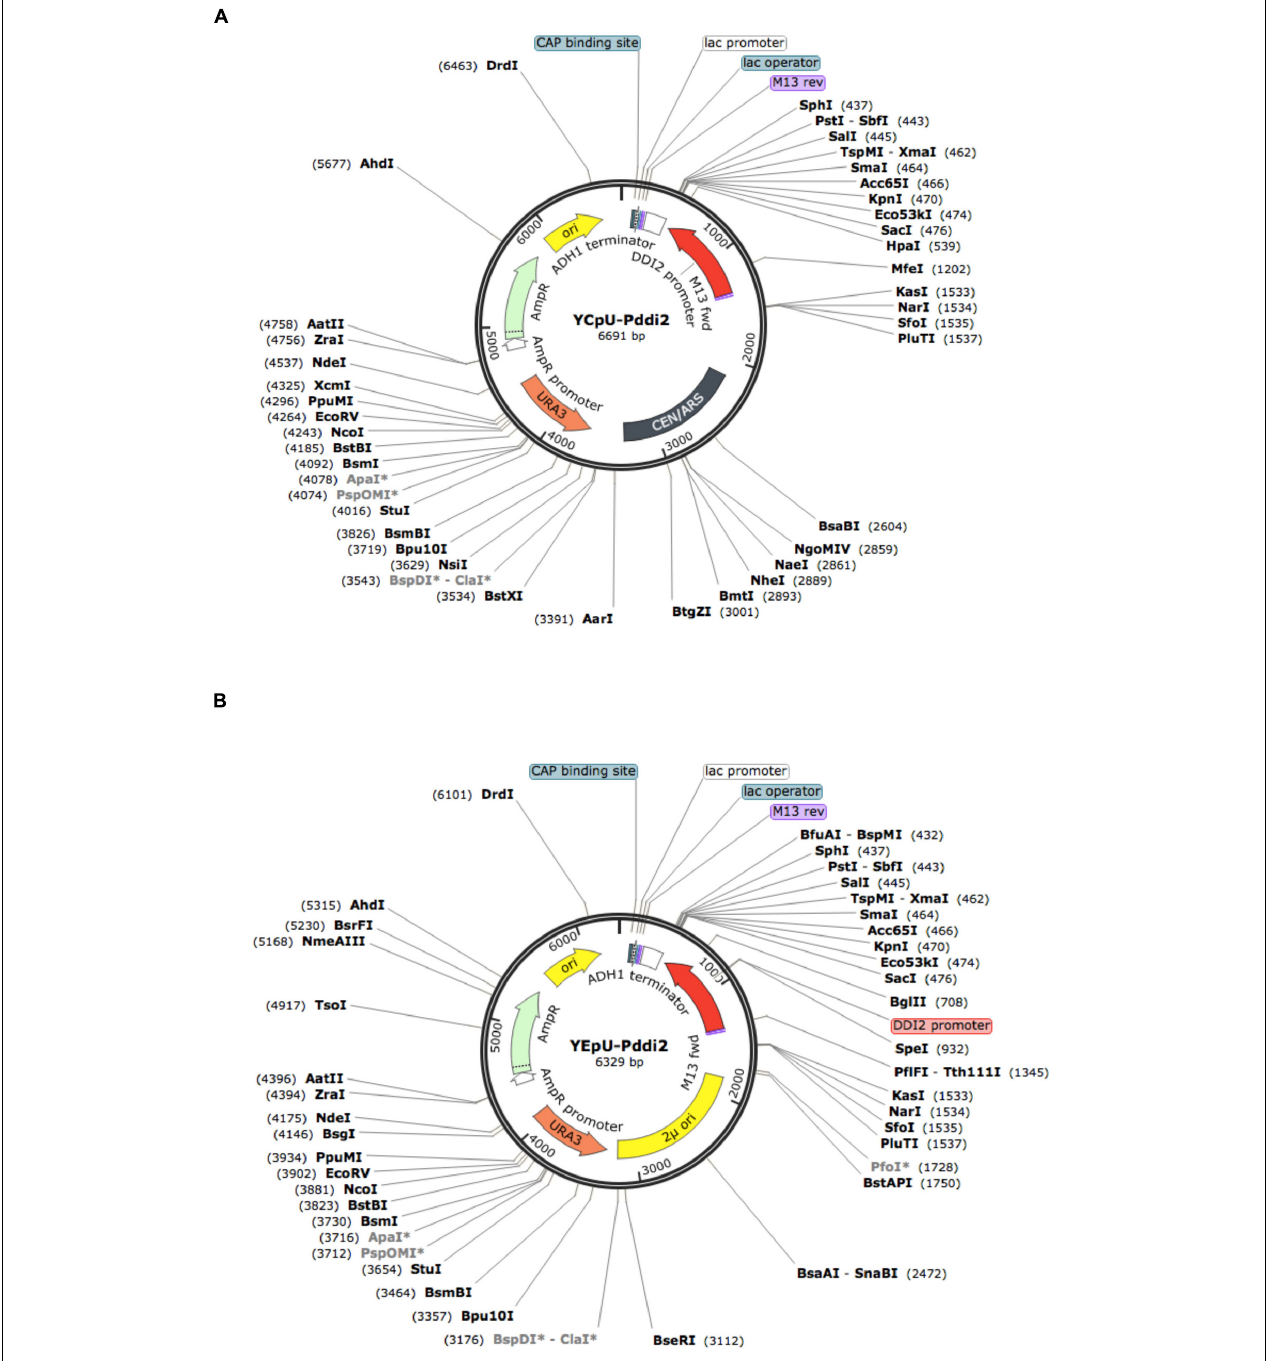
FIGURE 2 | Physical maps of plasmids YCpU-P DDI2 and YEpU-P DDI2 . (A) A single-copy plasmid YCpU-P DDI2 . (B) A high-copy plasmid YEpU-P DDI2 . Functional regions are marked in the inner circle and restriction enzyme recognition sites are marked. The maps were drawn with SnapGene (GSL Biotech LLC).